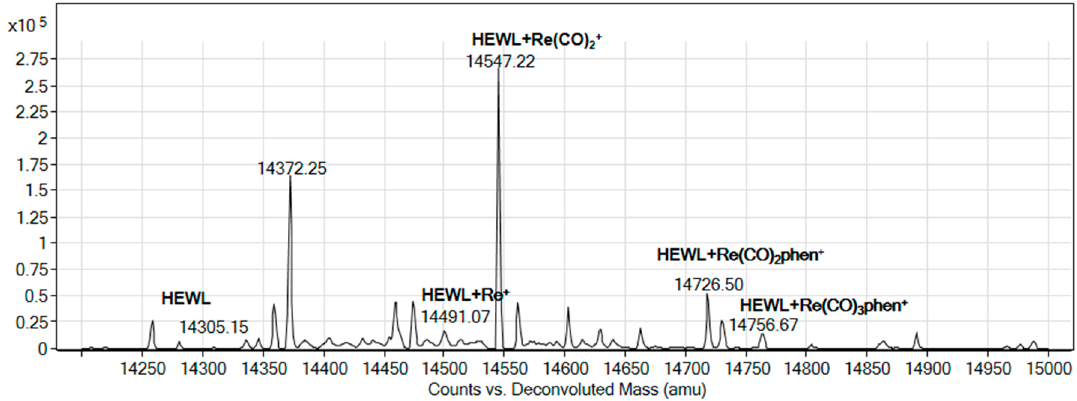
Figure 9. Deconvoluted electrospray ionization mass spectrometry (ESI-MS) spectra of HEWL (1 × 10 − 4 M) incubated for 24 h at room temperature in the presence of compound 3 . Experimental conditions: protein to metal ratio 1:10, 20 mM ammonium acetate buffer, pH 6.8.